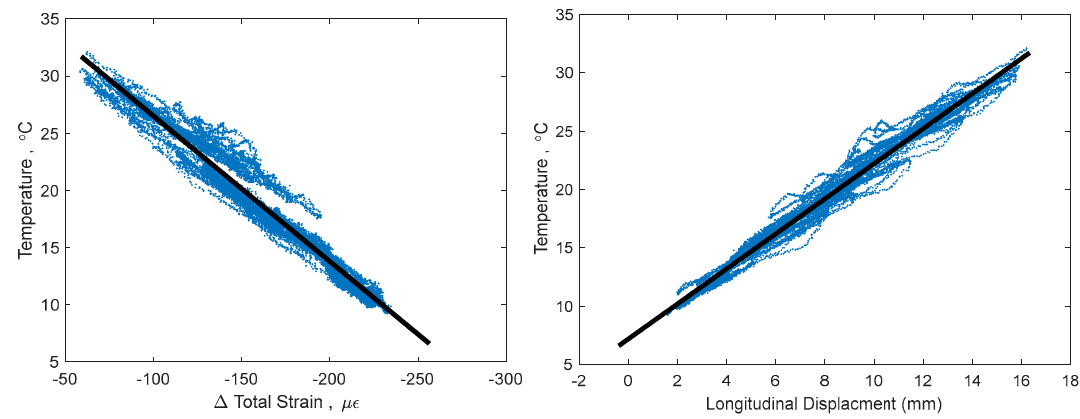
Figure 5. 2D projections of 3D signature, keeping temperature as the vertical axis.